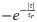
Emergence of oscillatory behavior in the voltage dynamics and a consequent ringing appears in the voltage correlation functions.(a) The frequency of the ringing increases with the strength of the intrinsic current (g = 0, 1, 5 shown; τ in units of τV). (b) The envelope of the ringing widens with τr (dashed lines are −e−|τ|τr;ω
Lτr = 1, 2, 5 shown and τ in units of ωL-1). Lines are Eq (37); dots are numerics.